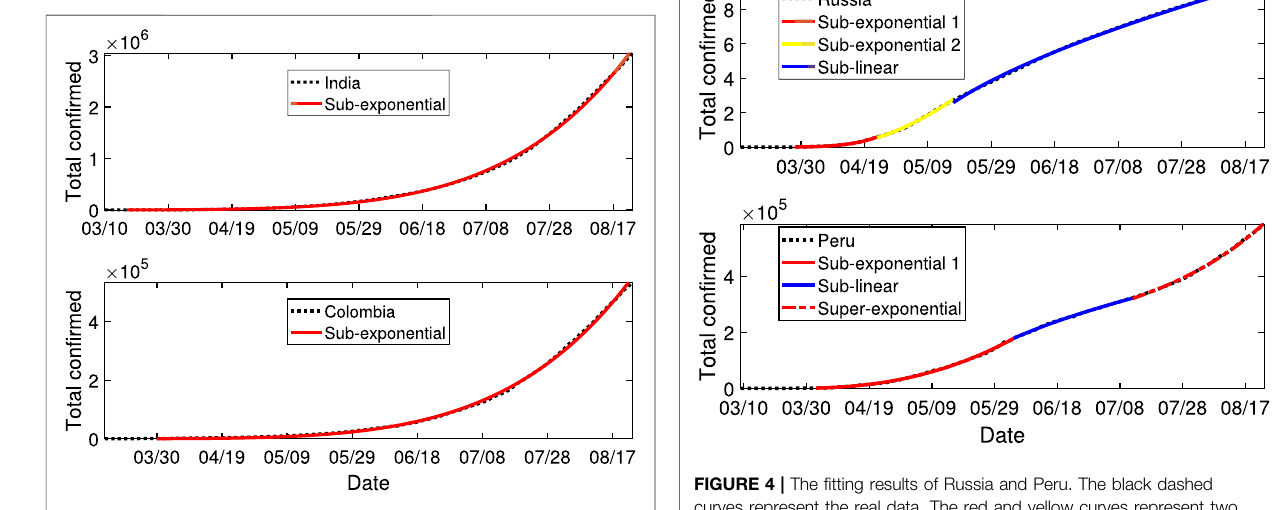
FIGURE 2 | The fi tting results of India and Colombia. The black dashed curves represent the real data. The red curves represent the sub-exponential growth of the total con fi rmed cases changing with time. The parameters and dates in consideration for different cases are listed in Table 1 .